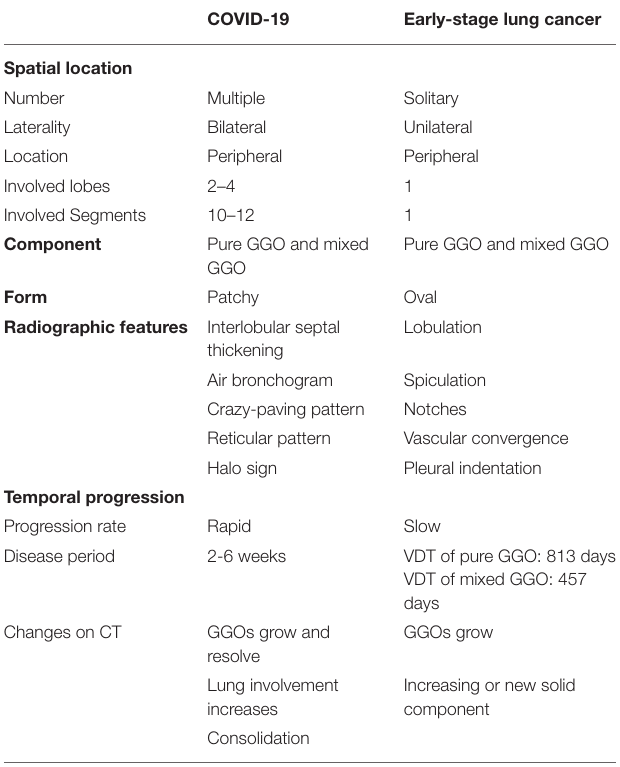
TABLE 1 | Radiological differences between Coronavirus Disease-19 (COVID-19) and early-stage lung cancer with GGO